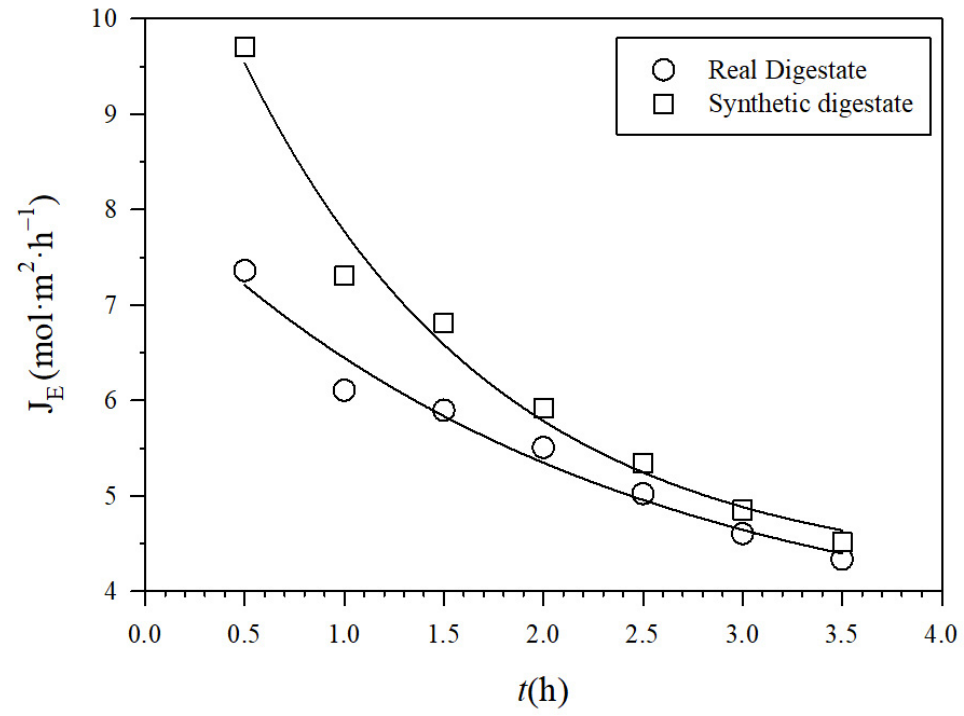
Figure 5. Experimental molar fluxes J E for recirculation rate 0.030 m 3 h − 1 for PTFE-0.22 at a pH of 10 and 1 M H 2 SO 4 .